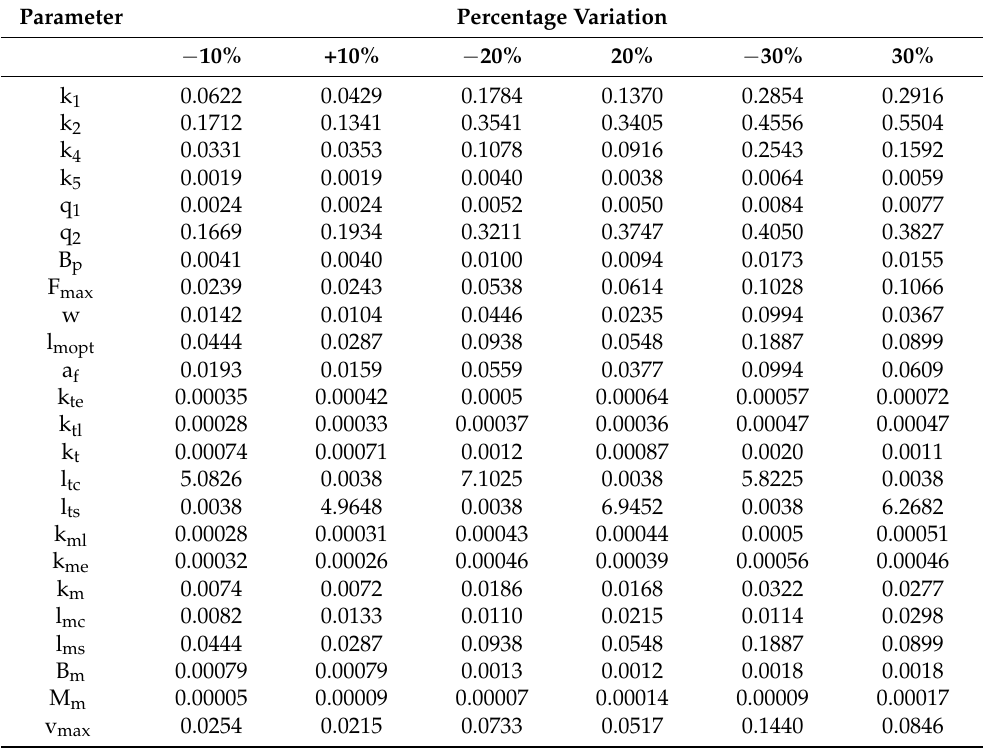
Figure 5. An example of WMFT8m movement pattern: mean value (bold line) and standard deviation (shaded area) of ( A ) measured and estimated elbow angle; ( B ) elbow joint stiffness; ( C ) total joint torque. The presented signals belong to participant 9 for task E1 and have a tempo of 30 bpm. The comparative analysis of stiffness accuracy in relation to the change in model pa ‐ rameter values is presented in Table 4. The values of the model parameters were modified for ±10%, ±20%, and ±30% regarding the parameter values estimated by GA. The accuracy of the stiffness was calculated using the DTW algorithm, comparing the estimated stiff ‐ ness values using GA and stiffness calculated from modified parameters. The results show that stiffness sensitivity increases with the increase or decrease in each of the parameters. The stiffness is more sensitive to changes in the k 1 , k 2 , k 4 , q 2 , l tc , l ts , F max , l mopt , l ms , and v max